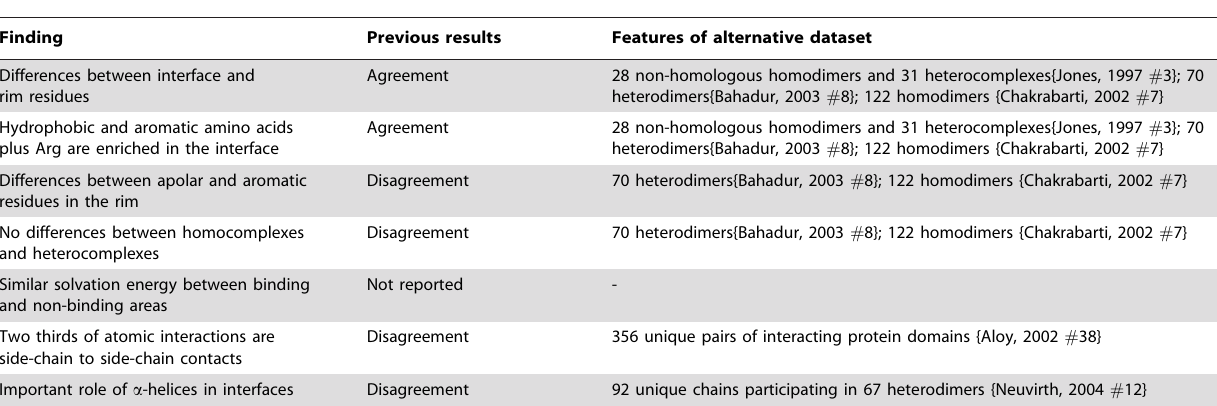
Table 4. Summary of main conclusions drawn by this work and comparison with previous